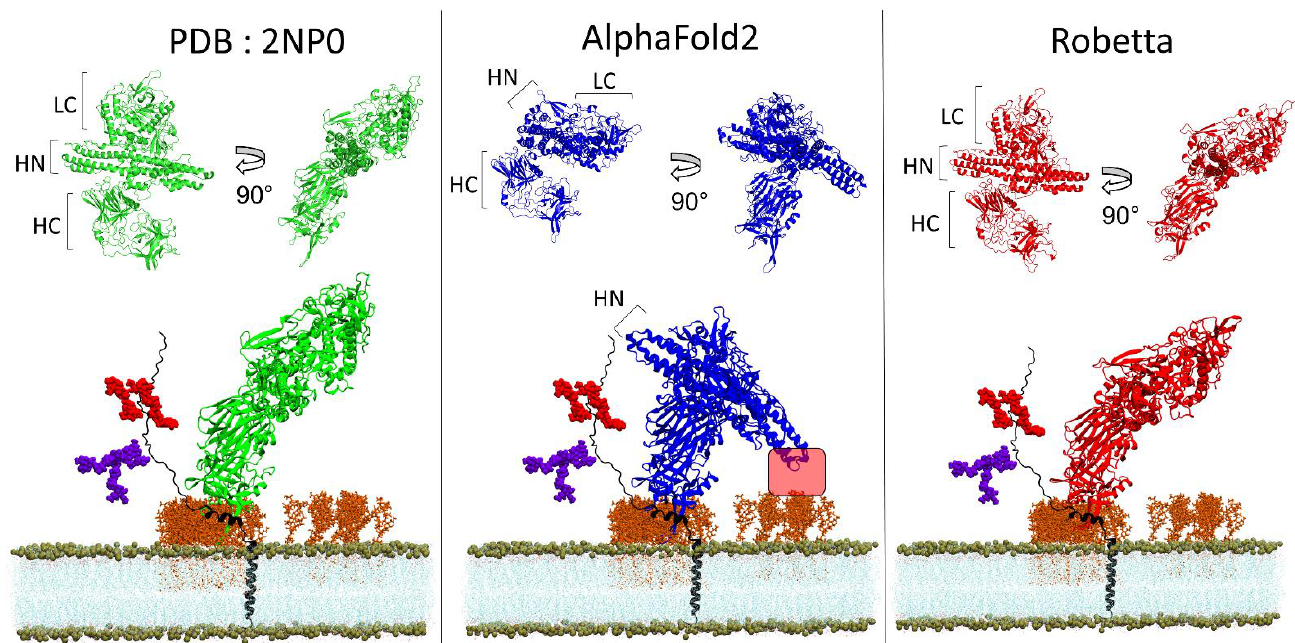
Figure 6. Structural comparison of the spatial organization of the domains of botulinum neurotoxin B obtained from Xray diffraction (PDB: 2NP0) ( left ), AlphaFold2 ( middle ) and Robetta ( right ) and molecular modeling of each structure with its membrane receptor human synaptotagmin 1 in a neural membrane context. The toxin receptor h-SYT1 is depicted as cartoon colored in black. The phosphate atom of each POPC lipids is shown as brown spheres. The GT1b molecules are represented as orange sticks, the lipid tails of POPC molecules are shown as thin blue lines and the N-glycan and O-glycan of h-SYT1 are depicted as purple and red spheres respectively.